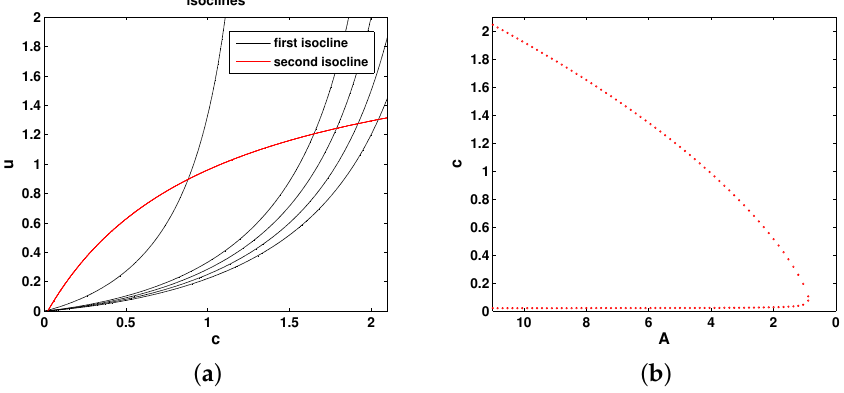
Figure 2. ( a ) The (null)-isoclines of the oxygen-phytoplankton system for Model 1. Black curves show the oxygen isocline ( u I ) for A = 3.5,8,9,10 and 11 (from left to right, respectively), and the red curve shows the phytoplankton isocline ( u II ). ( b ) Positive steady states of Equations (5) and (6) shown as functions of A . Other parameters are c 1 = 1, B = 12.5, γ = 2.5, m = 1 and σ =